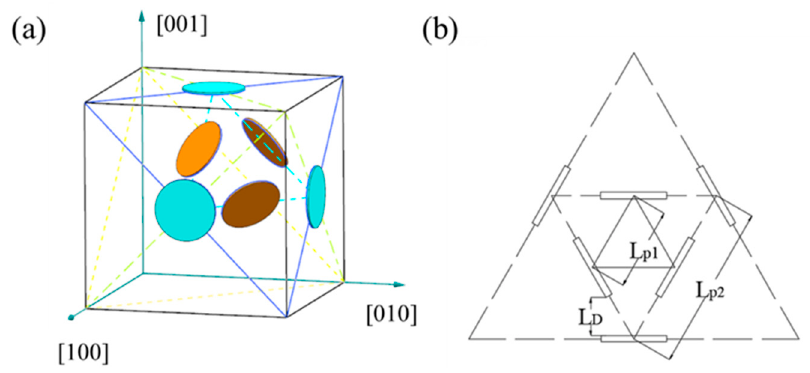
Figure 4. ( a ) Schematic diagram of the shape of T1 and θ (cid:48) phases and their position in the aluminum matrix; ( b ) schematic section of T1 and θ (cid:48) phases on the slip plane